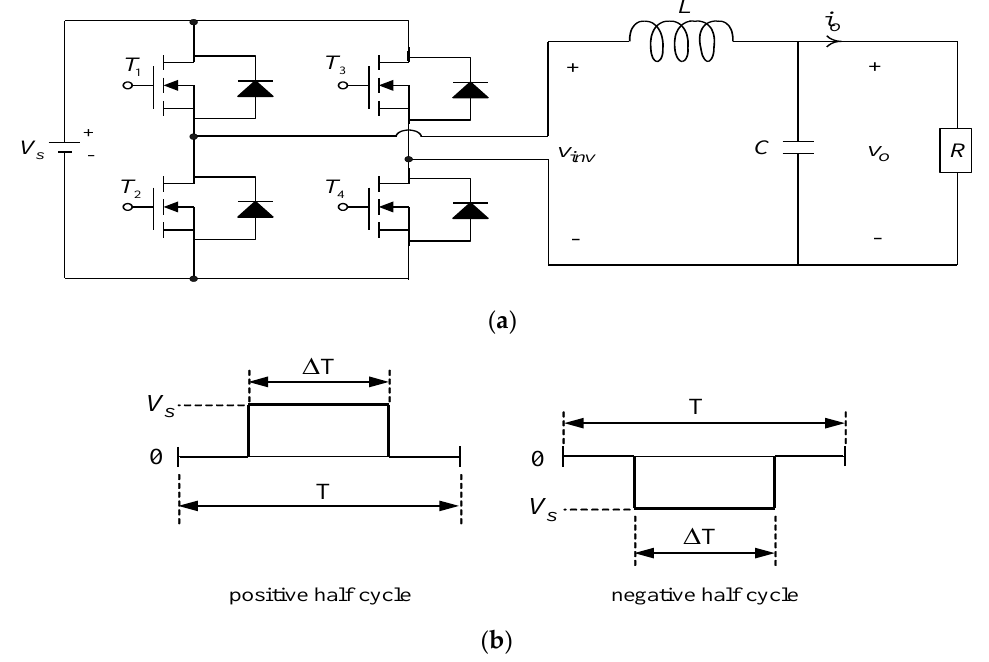
Figure 1. Construction of voltage source inverter (VSI) ( a ) Circuit diagram ( V s : DC-bus voltage, v inv : equivalent output voltage of pulse width modulation, v o : output voltage, i o : output current and R : load); ( b ) PWM (pulse width modulation) pattern ( T : sampling interval and ∆ T : width).